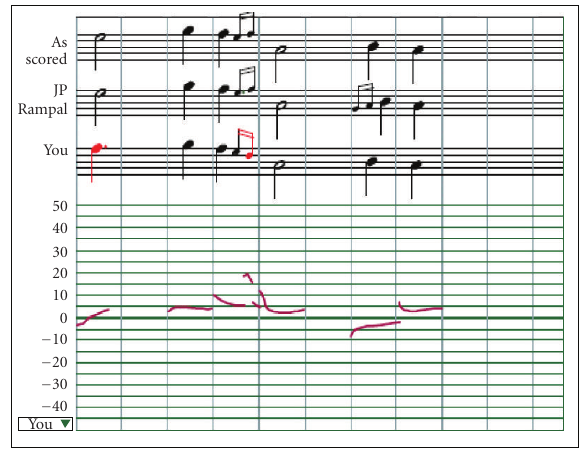
Figure 1: Intonation visualization section of the Visual Music game/toy.